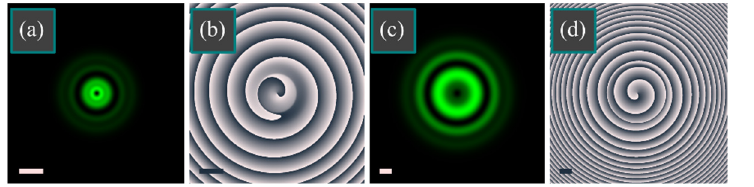
Figure 2. The same intensity ( a , c ) and phase ( b , d ) distributions as in Figure 1e,f ( a , b ) and as in Figure 1o,p ( c , d ), but obtained analytically by Equation (7) using the expansion coefficients (8).